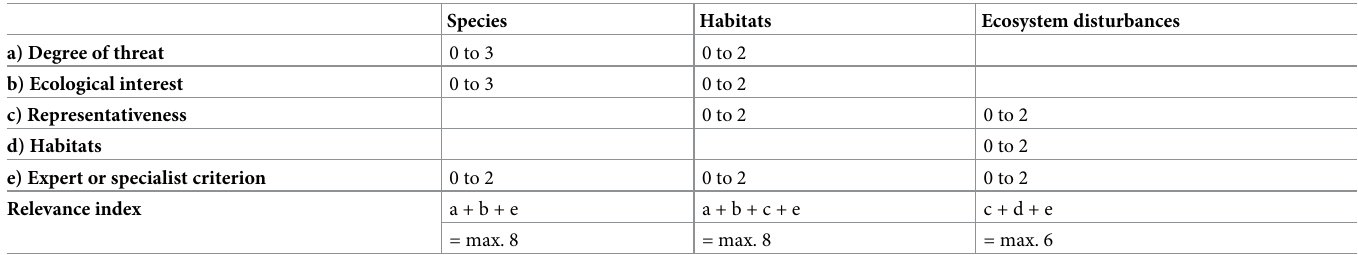
Table 1. The quantitative scoring ranges and the relevance index formula used in our multi-criteria analysis for the relevant candidates of species, habitats, and eco- system disturbances. Species